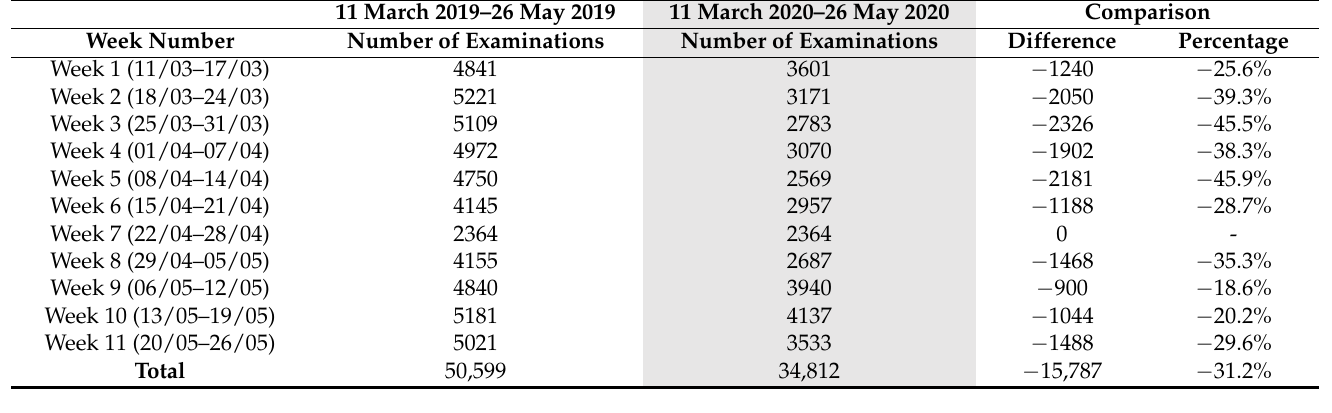
Table 2. Number of diagnostic investigations performed per week within the ordinary activity (11 2020) by the radiology department of our institution; the comparisons between the two-time intervals are expressed both in absolute values and in percentages.